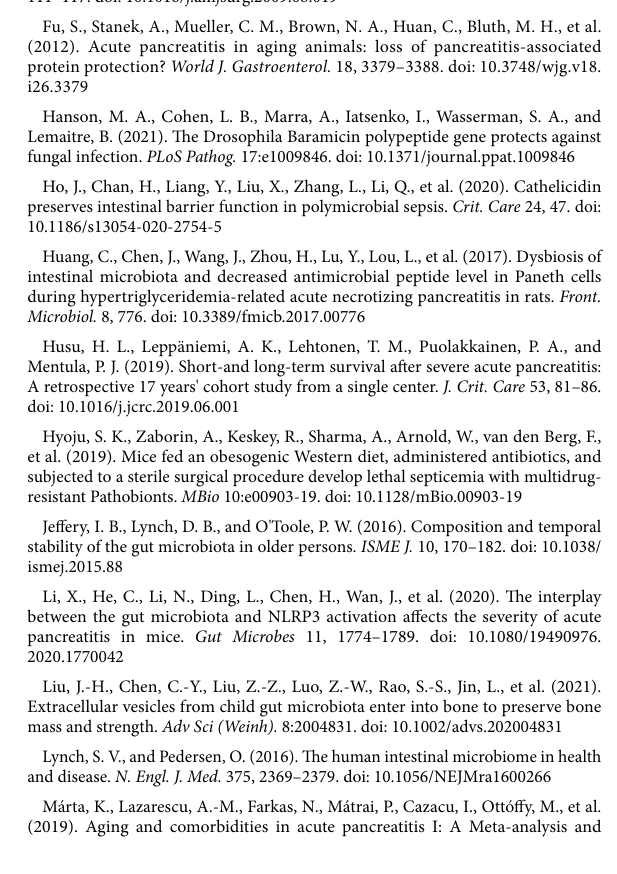
SUPPLEMENTARY FIGURE S1 The rarefaction curve of samples. SUPPLEMENTARY FIGURE S2 (A) The 16SrDNA general PCR results of mice stool samples after antibiotic treatment. (B) The FMT homology analysis by SourceTracker. (C) The typical plate images of abx treatment. SUPPLEMENTARY FIGURE S3 (A) Anatomical images in mice in the young group on day 4. (B) Typical pathological image of two groups on day 4. SUPPLEMENTARY FIGURE S4 (A) Typical pathological image of two groups had antibiotic treatment after disease